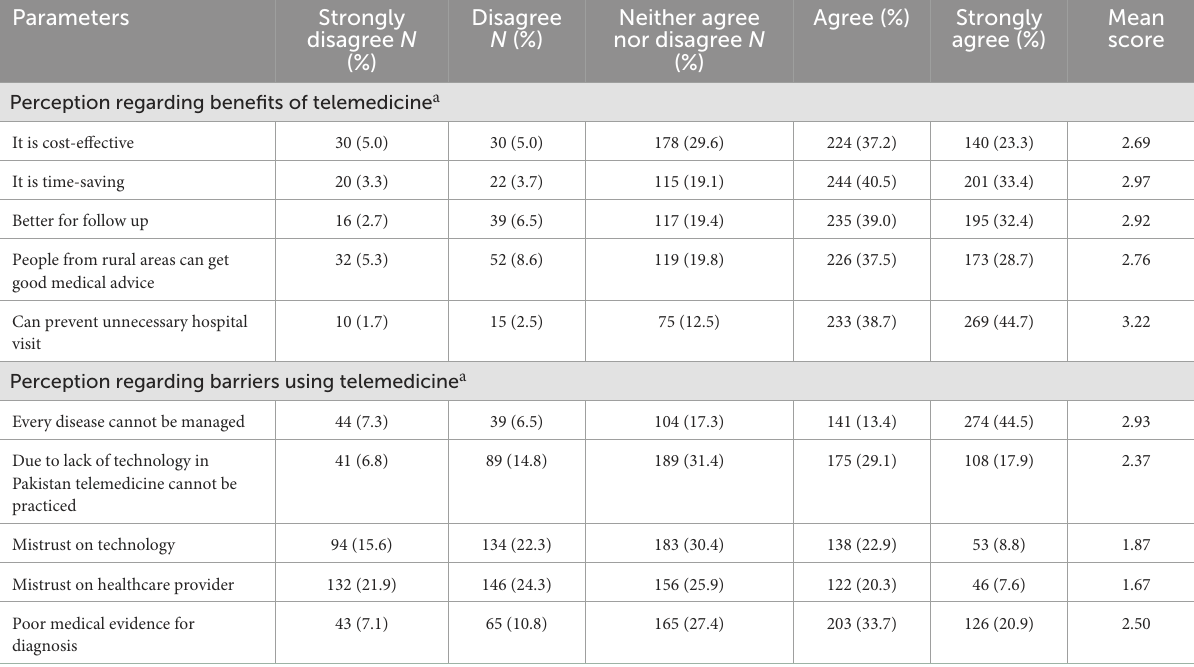
TABLE 4 Perception of benefits and barriers regarding telemedicine among participants ( N =